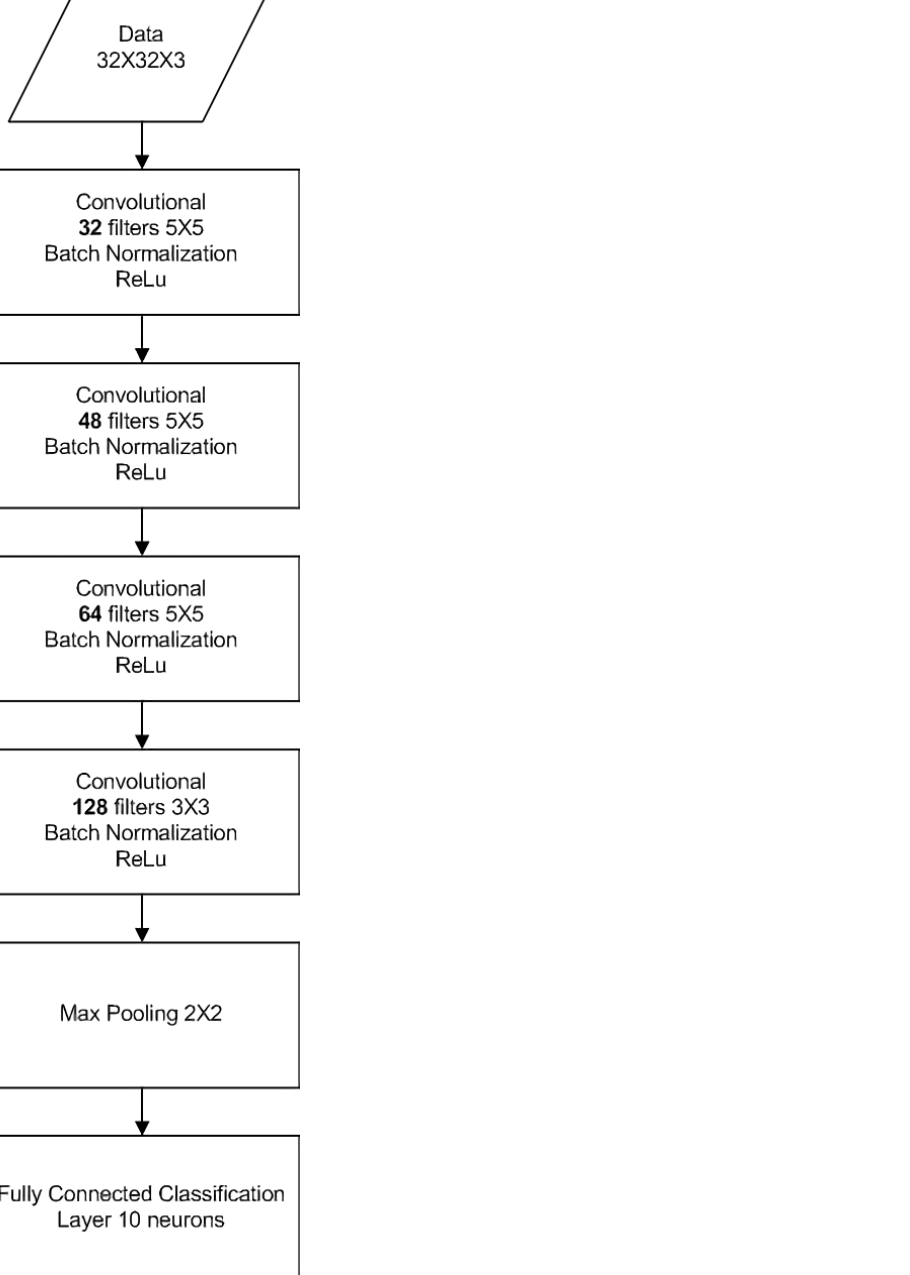
Figure 7. Manually optimized CNN architecture to validate the layer capacity model of